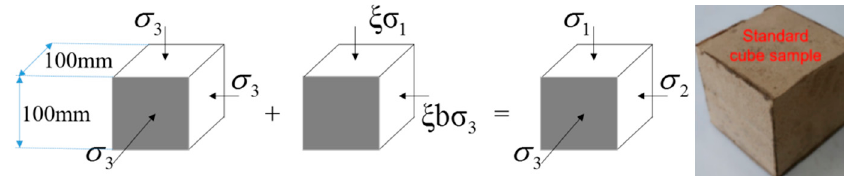
Figure 1. Test loading method.